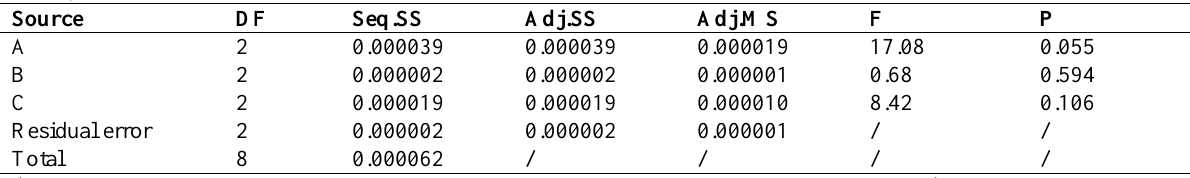
Analysis of Variance for Means (MRR)